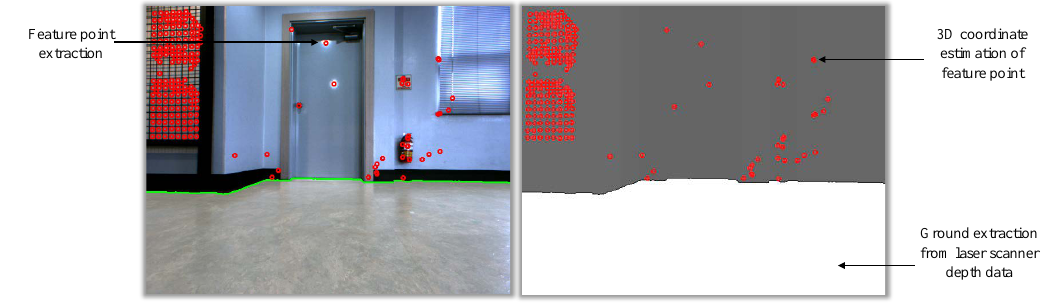
Figure 3. Extracted features on the wall in the image. Red circles indicate the extracted image feature points. The white region in the figure is the extracted ground. The gray region in the right side figure is the